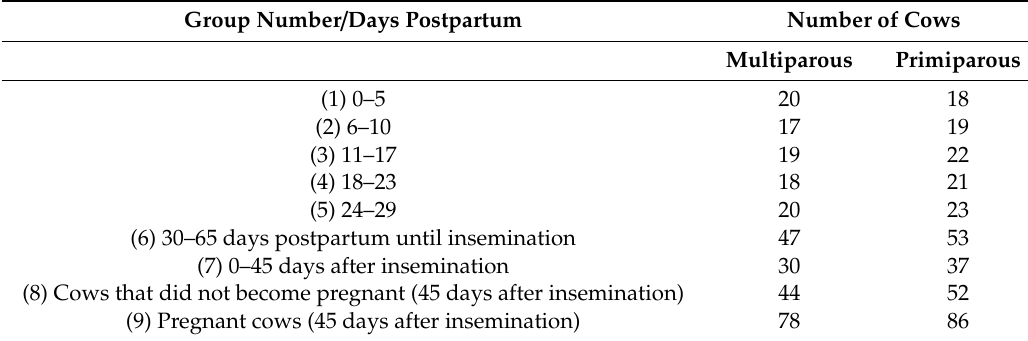
Table 1. Creation of experimental